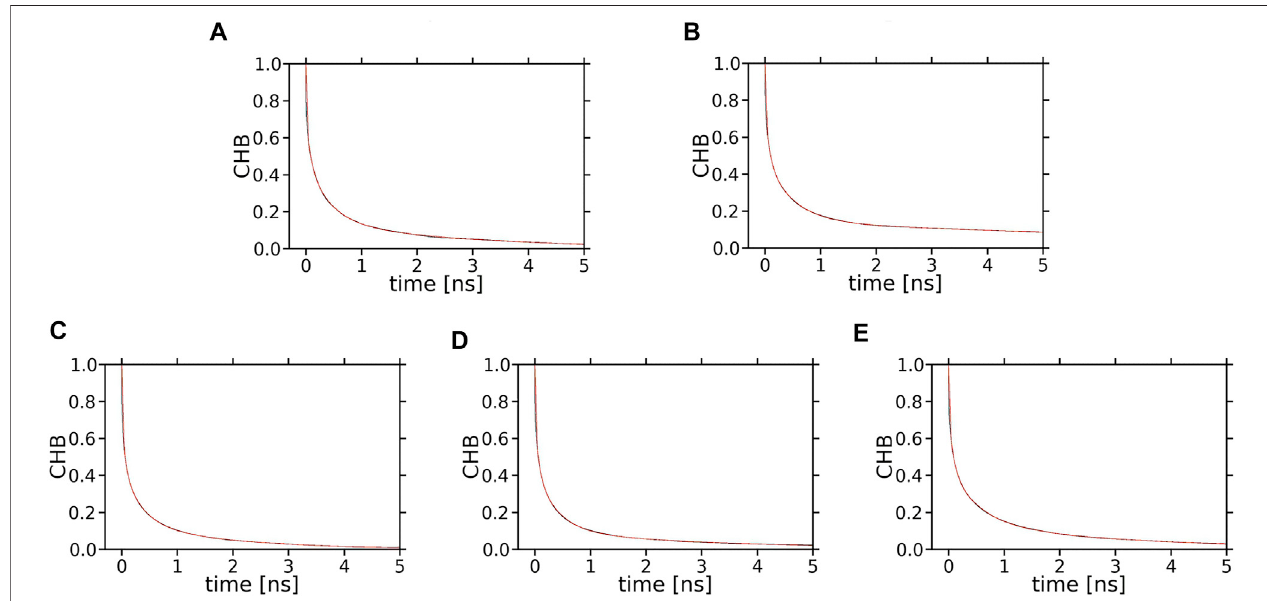
FIGURE 13 | Time pro fi les (decay curves) of the number of H-bonds between XAN-OH and water molecules hydrating the bilayer (CHB). (A) ε -ring, (B) ß -ring, of lutein in the horizontal orientation; (C) ε -ring, (D) ß -ring, of lutein in the vertical orientation; (E) ß -ring, of zeaxanthin in the vertical orientation. Each decay curve ( black ) of the initial number of water molecules H-bonded to the ε -ring or ß -ring of lutein or zeaxanthin is fi tted to a sum of four exponentials ( red ); the black and red curves are superimposed and overlap with each other, which indicates that the quality of fi ts is high.